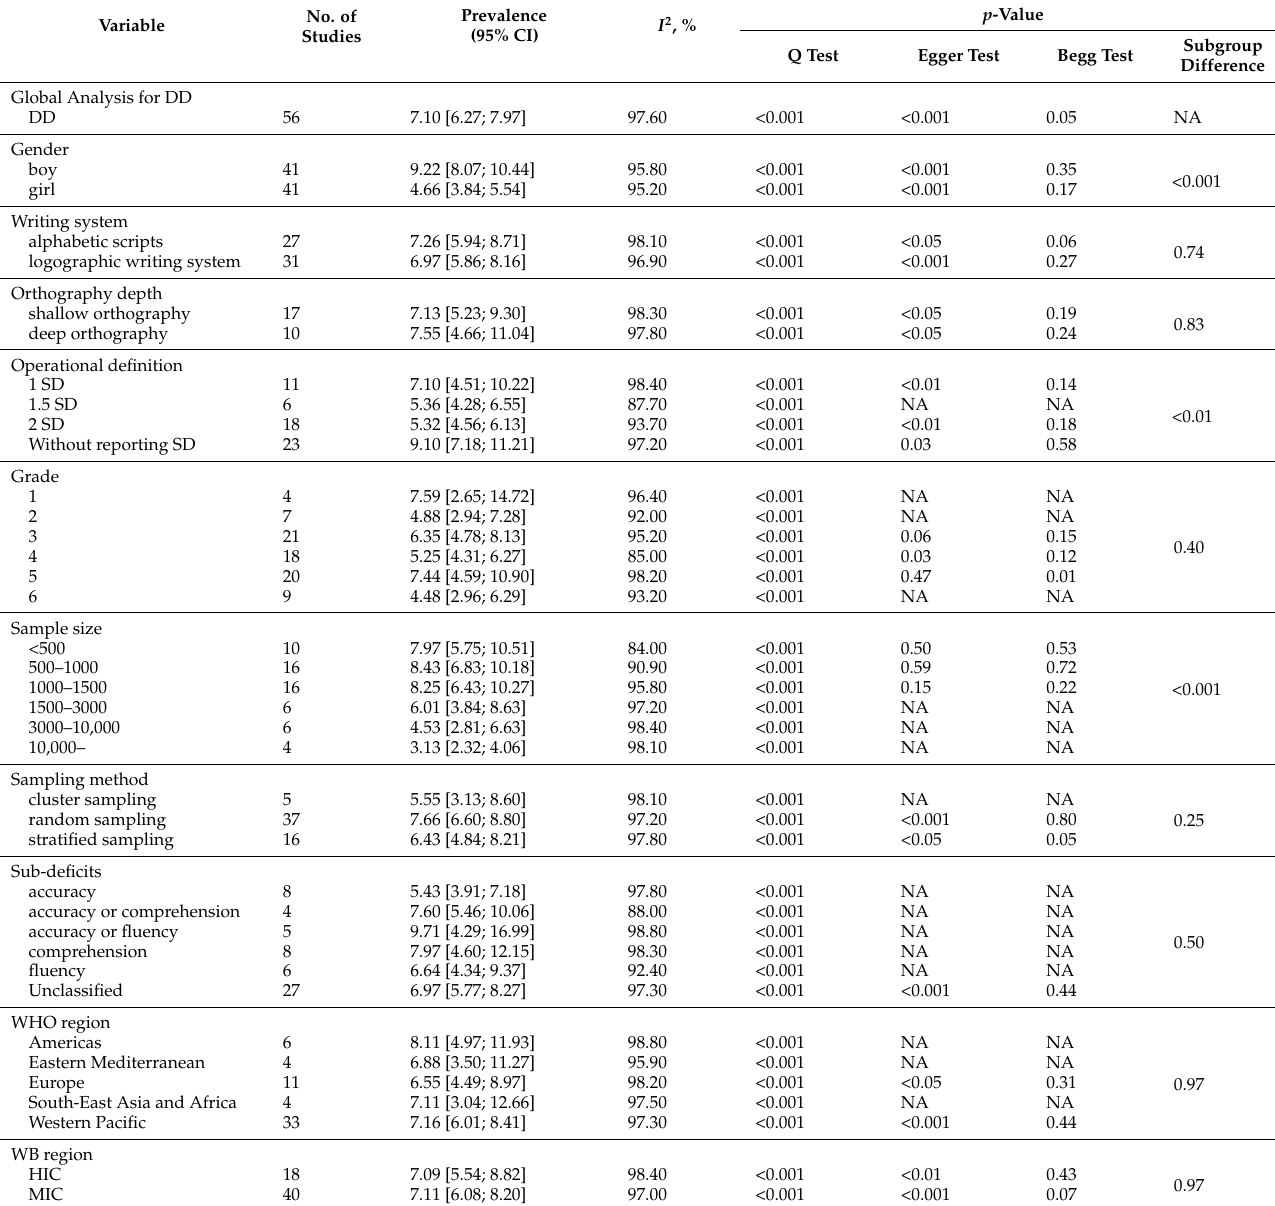
Table 1. Prevalence of DD using random-effects meta-analysis and subgroup